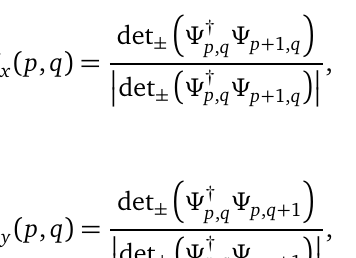
Figure 9: The calculated Berry phase γ along the x -direction of the Bril- louin zone as a function of W the three gapped phases at densities (a) 1 / 4, (b) 1 / 2 and (c) 3 /